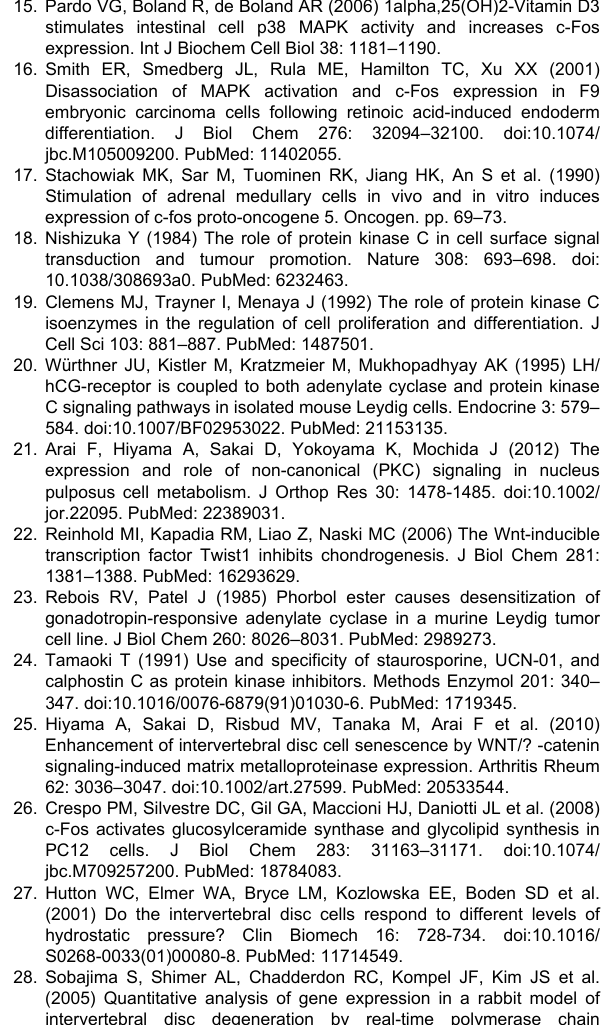
Figure S3. Histology of rat IVDs. Female Sprangue Dawly (SD) rats (3 and 48 weeks old) were used. Sections of IVDs were stained with hematoxylin and eosin (H (cid:0) E) for cell structure and safranin-O (SO) for proteoglycan content. IVDs exhibited a decreased number of notochordal cells with aging, and an age- related decrease in sulfated PGs stained with SO was